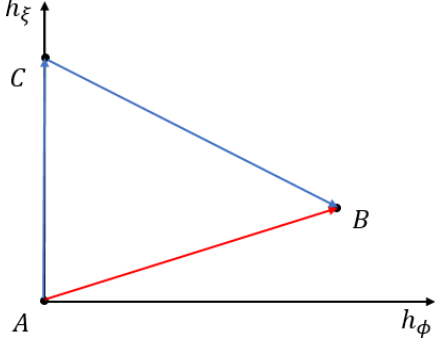
Figure 1 . One-step (red) and two-step phase (blue) transition process. A is the original point, which is SU(2) L (cid:2) SU(2) R preserving vacuum. B is the EW vacuum and C is the SU(2) V preserving